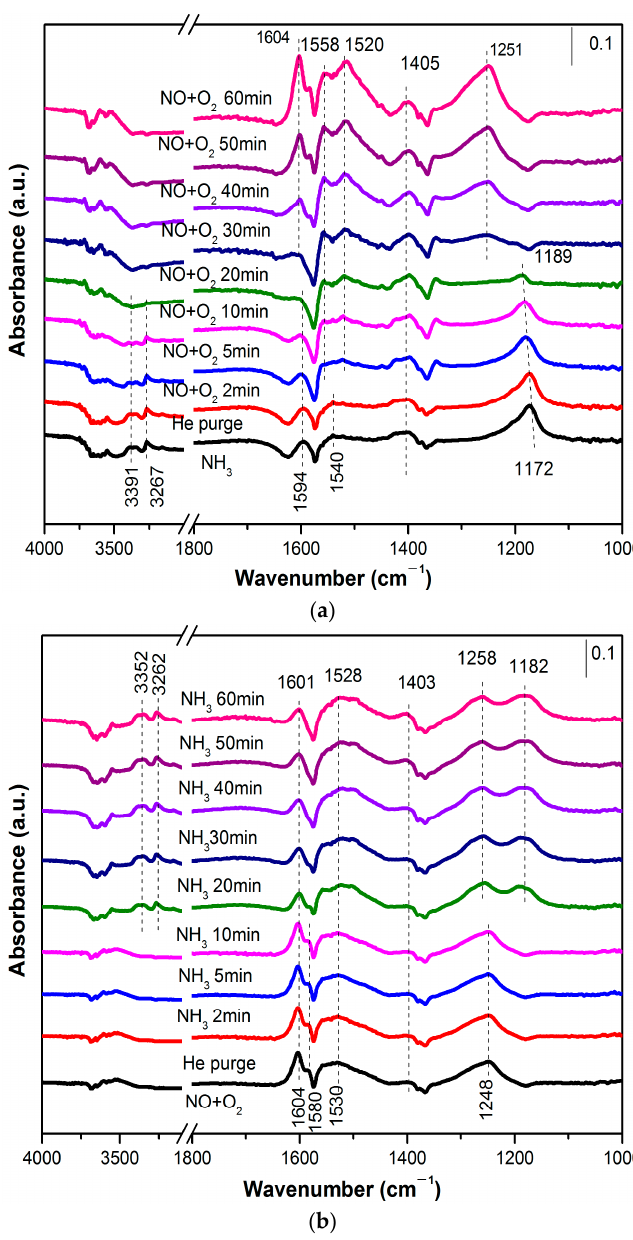
Figure 8. In-situ diffuse reflectance infrared Fourier transform spectra (DRIFTS) of NO + O 2 reacted with pre-adsorbed NH 3 species over MCTO-600 ( a ). In-situ DRIFTS of NH 3 reacted with pre-adsorbed NO + O 2 over MCTO-600 ( b ). Reaction conditions: T = 200 °C, 500 ppm of NO (when used), 500 ppm of NH 3 (when used), 5 vol. % of O 2 (when used), balance N 2 . Similarly, the transient SCR reaction of NH 3 with pre-adsorbed NO + O 2 on the MCTO-600 catalyst was recorded by in-situ DRIFTS, and the results of the reaction at different times are shown in Figure 8b. After the MCTO-600 catalyst was pretreated by NO + O 2 , bridged nitrate species (1248 cm − 1 ), monodentate nitrate species (1403 and 1530 cm − 1 ), bidentate nitrate species (1580 cm − 1 ), and gaseous NO 2 (1604 cm − 1 ) species appeared on the catalyst surface. The co-existence of NH 3 -adsorbed peaks (coordinated NH 3 –L species at 1182, 3262, and 3352 cm − 1 ) and NO-adsorbed peaks (1403, 1528, and 1601 cm − 1 ) was found after NH 3 was introduced for 10 min, indicating that the Langmuir–